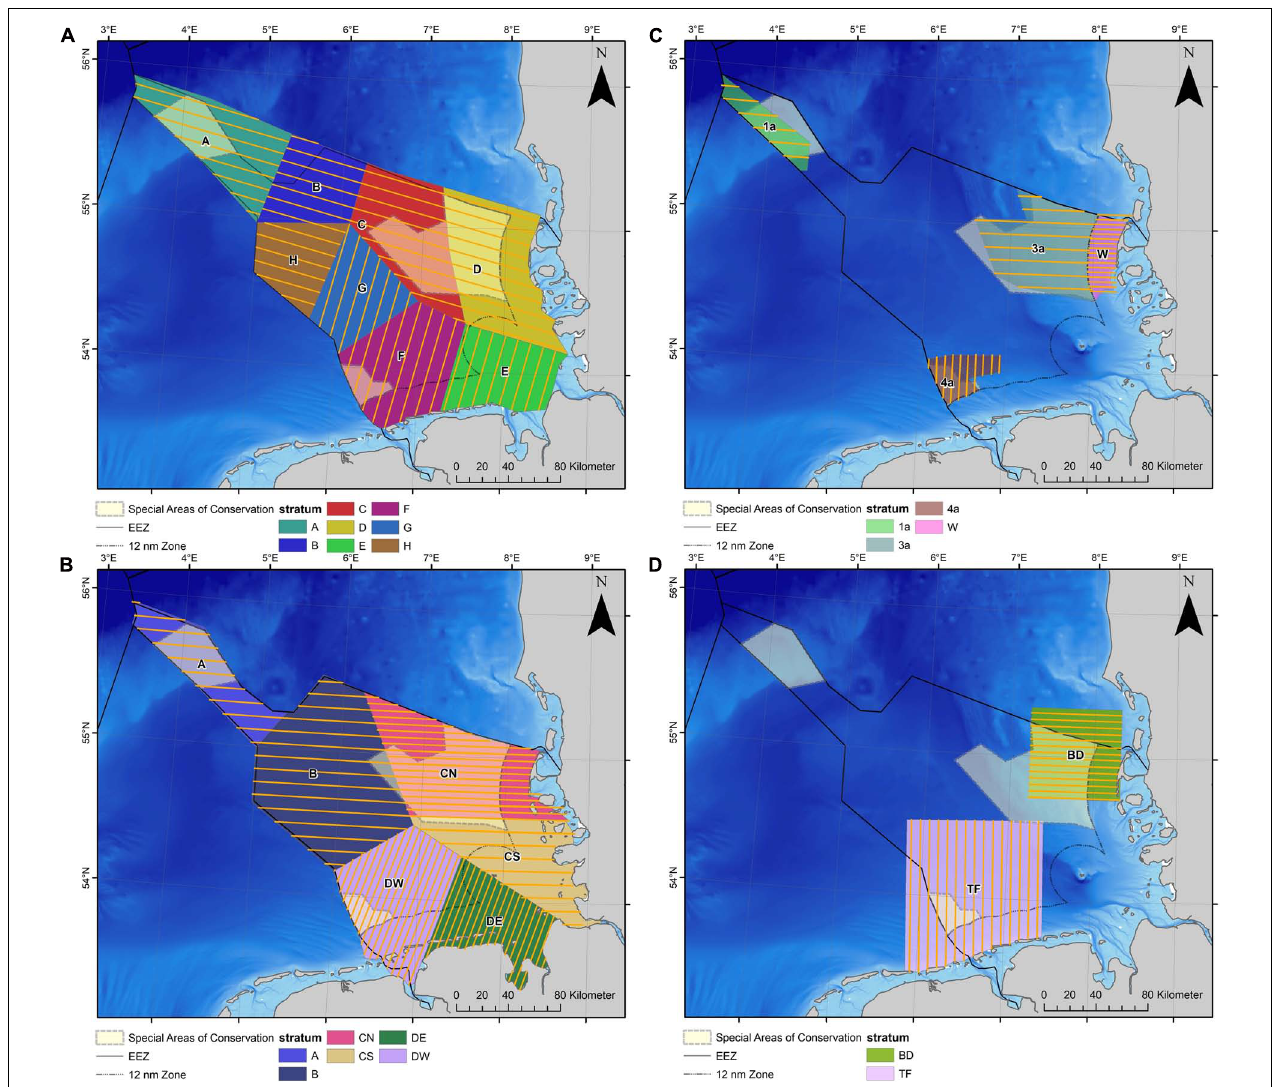
FIGURE 2 | Survey and transect design of the German visual monitoring of harbor porpoises and related research projects: (A) TopMarine, since 2017; (B) MINOS and TopSpace, 2002–2016 (Gilles et al., 2009); (C) EMSON (1a, 3a, and 4a) and whale protection area (W), 2002–2003; (D) alpha ventus OWF test field 2008–2012 (TF; Dähne et al., 2013) and Butendiek 2014 (BD; Viquerat et al.,